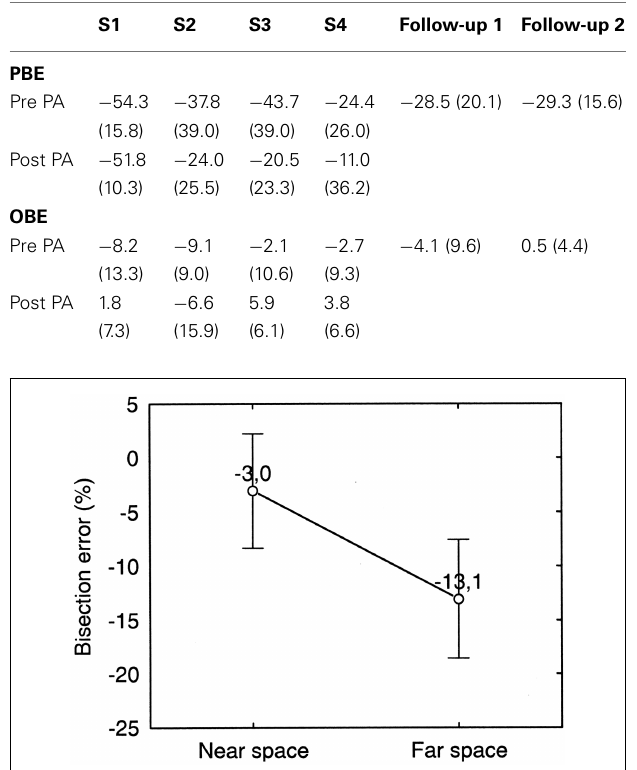
Table 3 | Bisection by walking in far space.